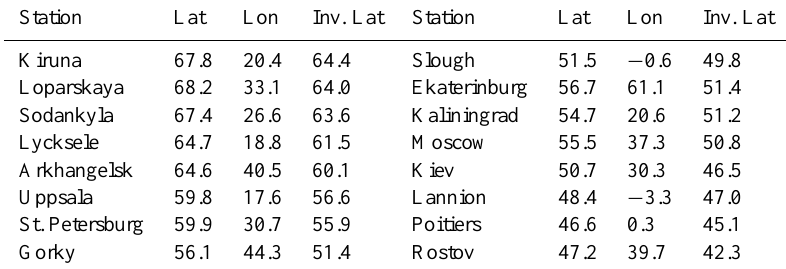
Table 1. List of stations used in the analysis, geodetic coordinates and invariant latitudes of the stations are given. Station Lat Lon Inv. Lat Station Lat Lon Inv. Lat Kiruna 67.8 20.4 64.4 Slough 51.5 − 0.6 49.8 Loparskaya 68.2 33.1 64.0